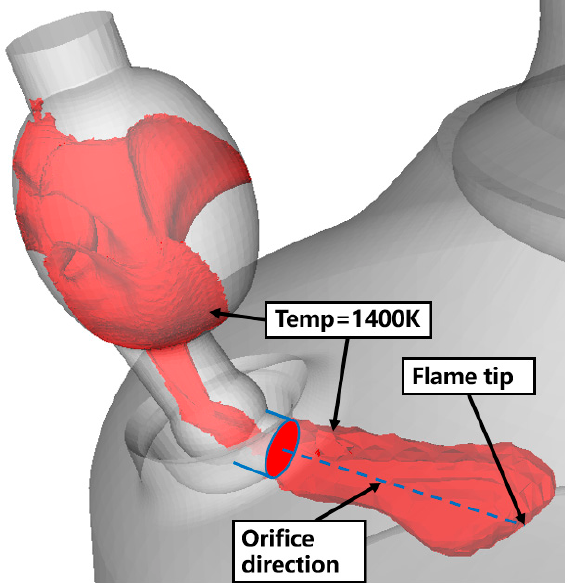
Figure 3. Isosurface of temperature at 1400 K (red) and the location of flame tip.